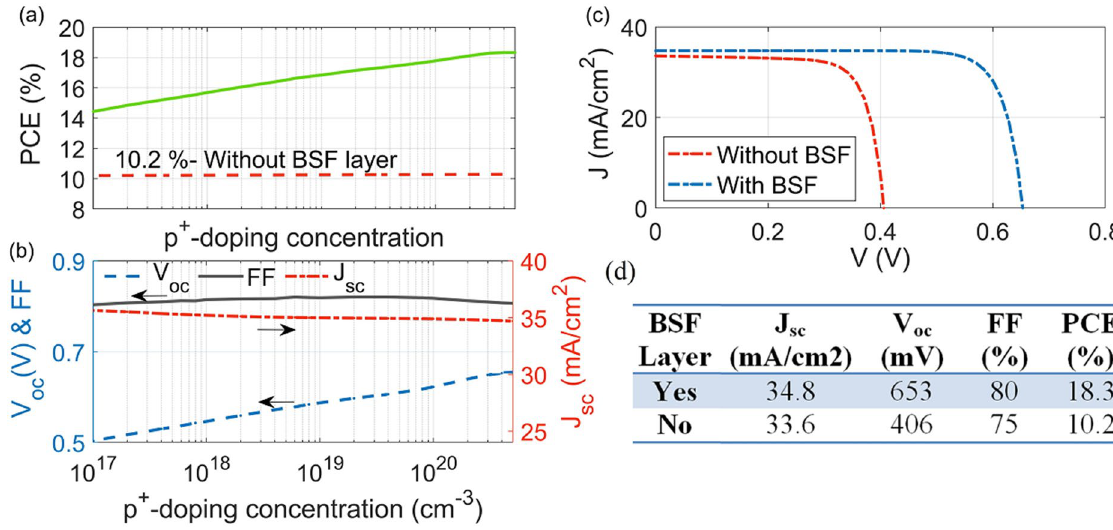
+ -doped BSF layer, ( c ) J–V characteristics and ( d ) numerical + = 4 × 10 20 cm − 3 ).